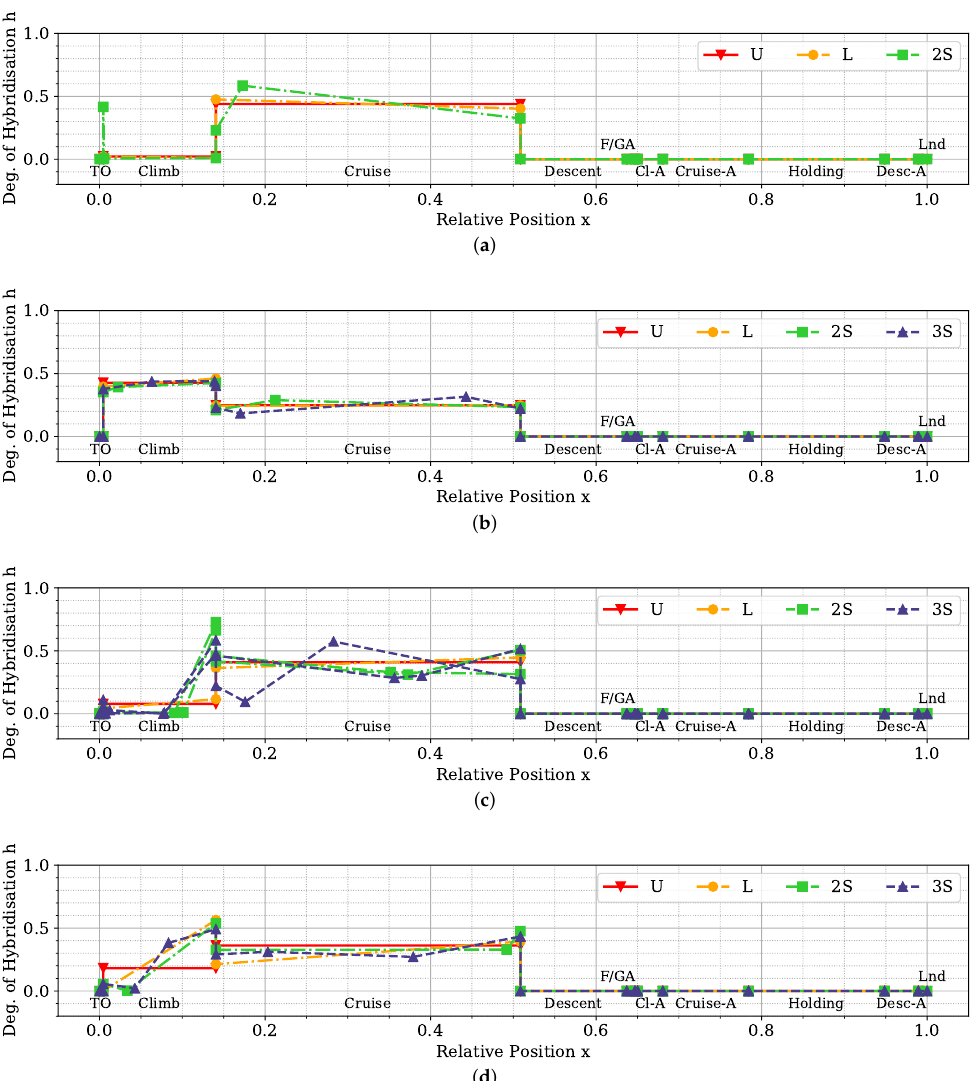
Figure 11. Optimal energy management strategies of Figure 9b: ( a ) Selection a; ( b ) Selection c; ( c ) Selections b and d; ( d ) Point closest to origin, marked with “X” in Figure